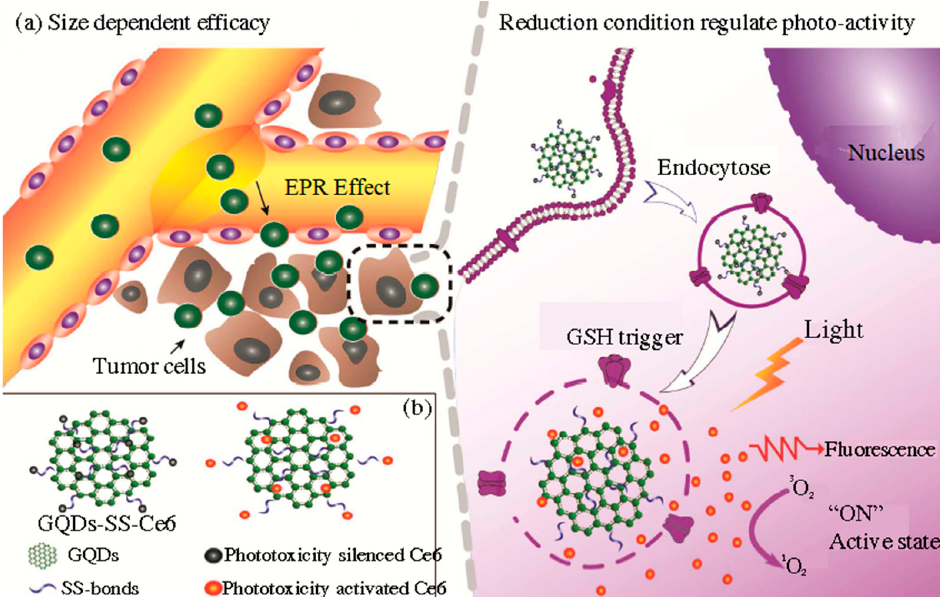
Figure 10. A complex of GQDs with Ce6 internalized into tumor tissue through FRET; Ce6 was released from the complex ( a ); a schematic presentation of the GQDs-SS-Ce6 complex ( b ). Reprinted with permission from ACS Applied Materials and Interfaces 8 , by Dou Du, Kun Wang, Ya Wen, Yan Li, and Yong Y. Li, Photodynamic Graphene Quantum Dot: Reduction Condition Regulated Photoactivity and Size Dependent Efficacy , 3287 [228] . Copyright 2016 with permission from the American Chemical Society.